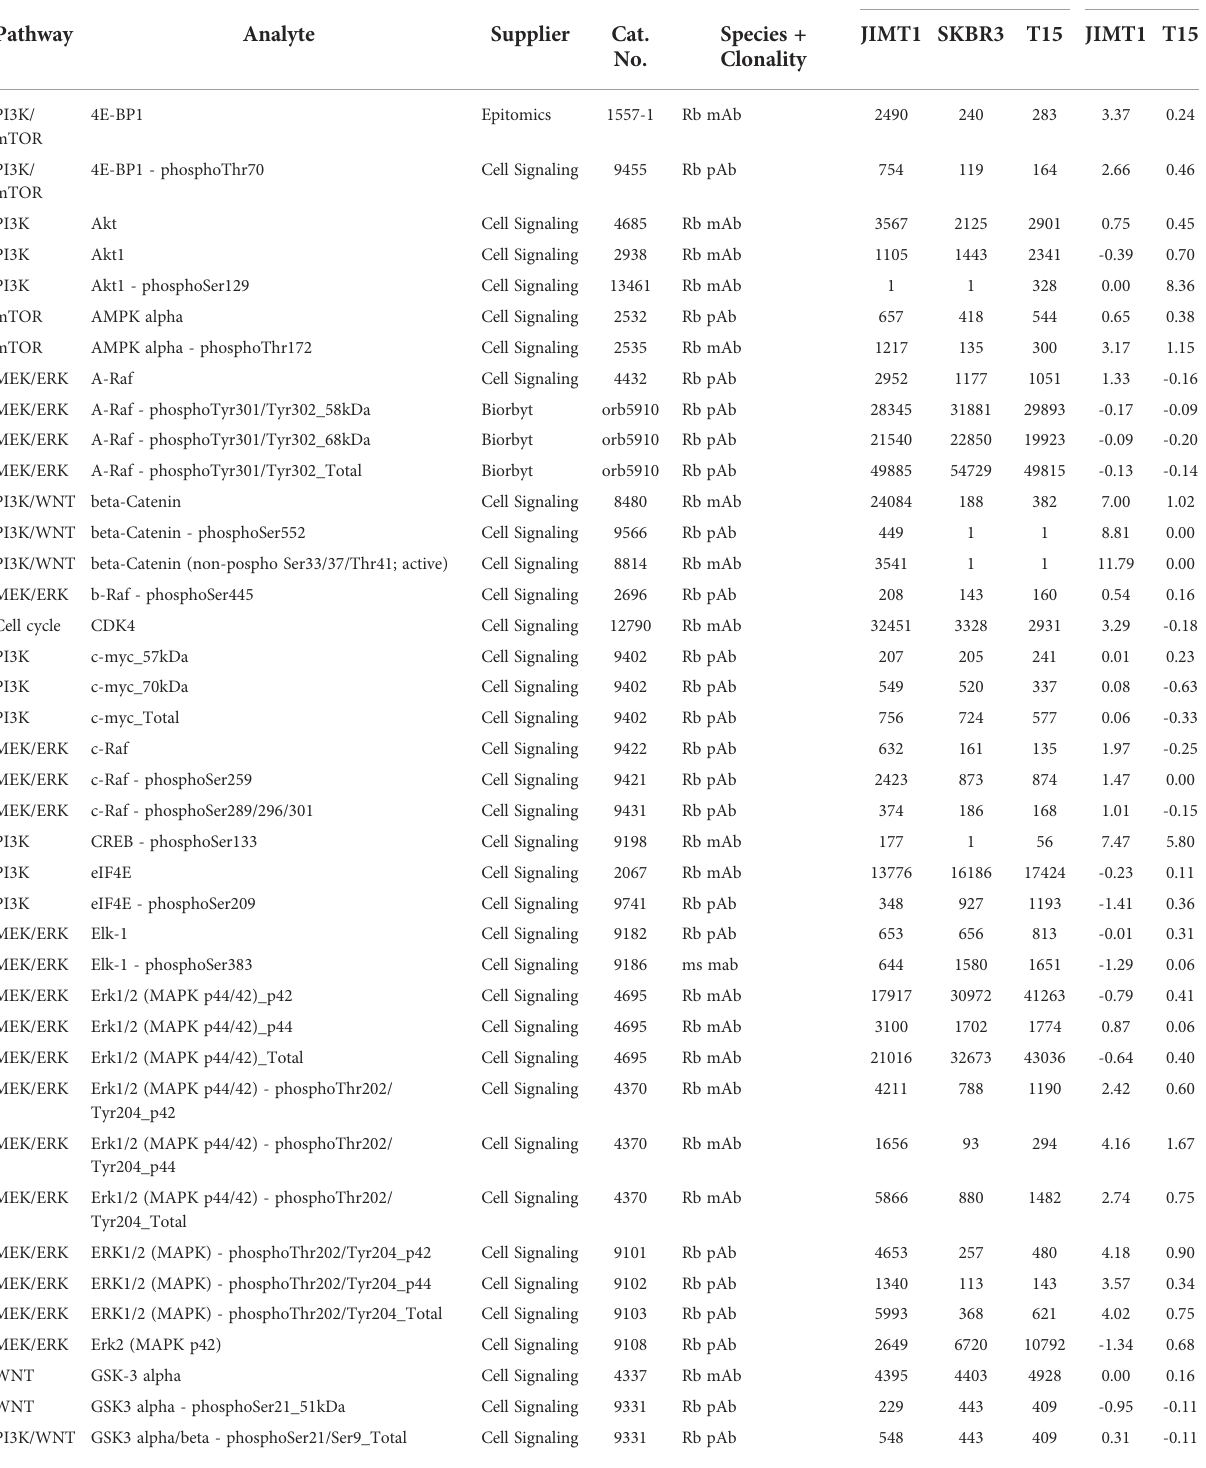
TABLE 1 Selected antibodies, fl uorescence intensities and Log 2 FC in protein & phosphoprotein quantities in T15 and JIMT-1 relative to